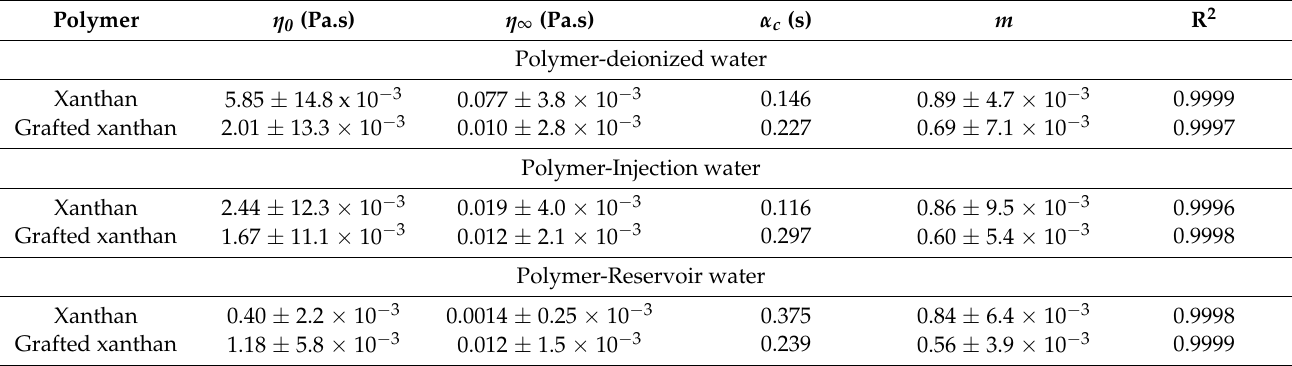
Table 7. Cross coefficients for 2000 ppm polymer solutions (T = 25 ◦ C).